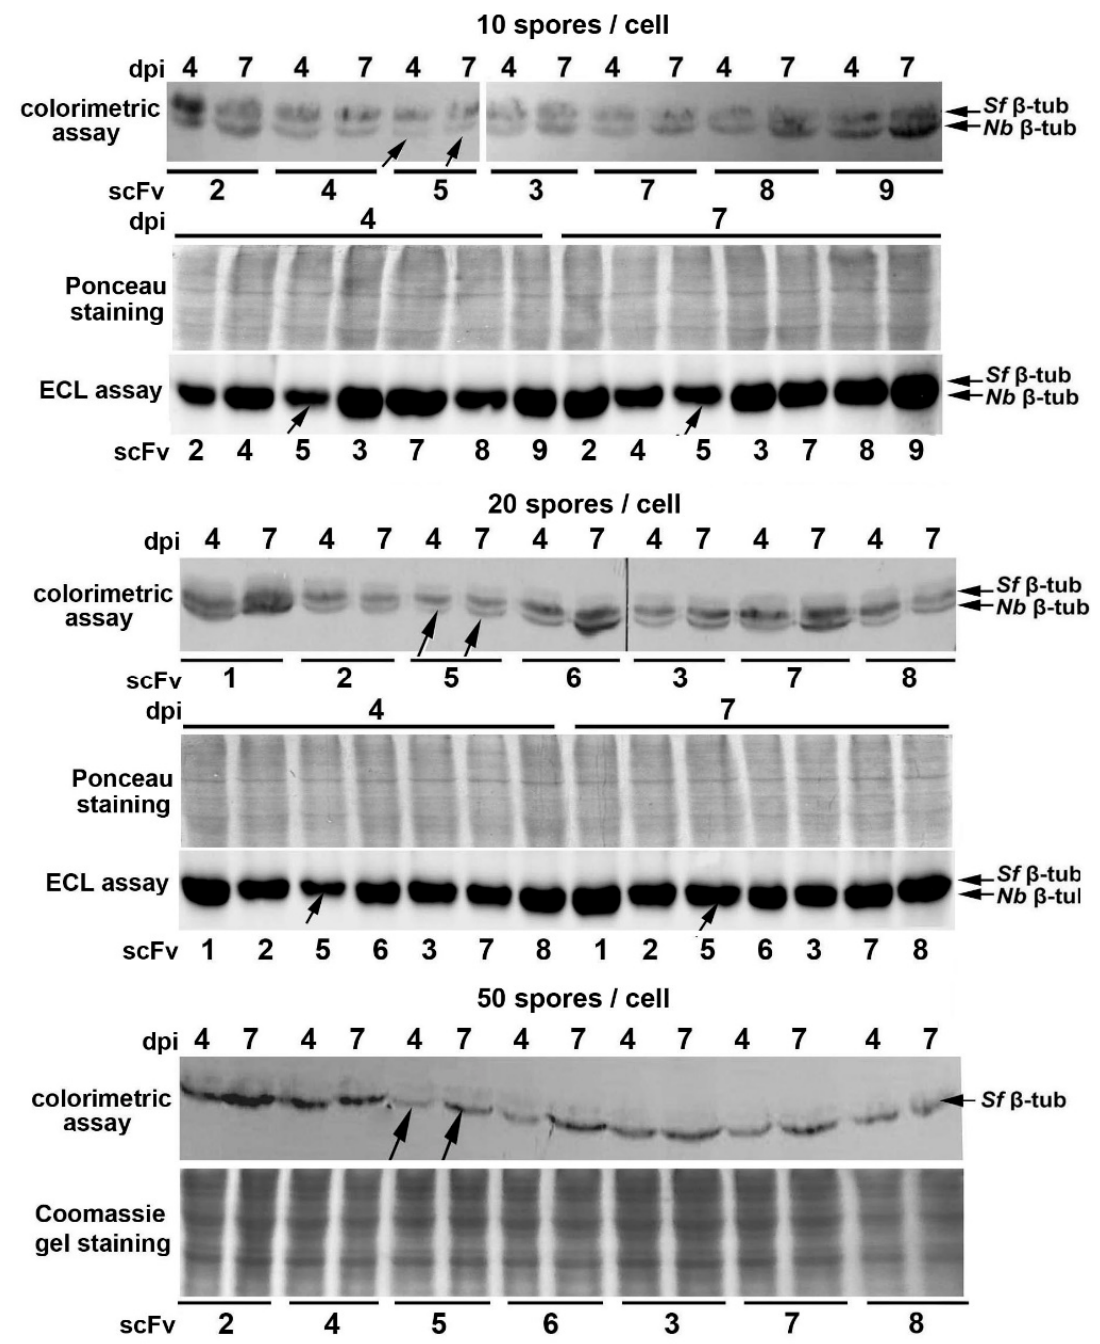
Figure 5. Western blot analysis with Abs against N. bombycis β -tubulin showed that in 6 experimental groups representing equal number of Sf9 transformants infected with three doses of spores and cultivated for 4 and 7 days, the lowest N. bombycis growth was observed in the case of scFv5 expression (marked by arrows). The lower detected bands corresponded to the parasite β -tubulin, and the upper one, to the S. frugiperda homologous protein [22]. To detect the HRP reaction, 4-chloro-1-naphthol as a colorimetric substrate or ChemiDoc MP Imaging System and Clarity™ Western ECL substrate were used.